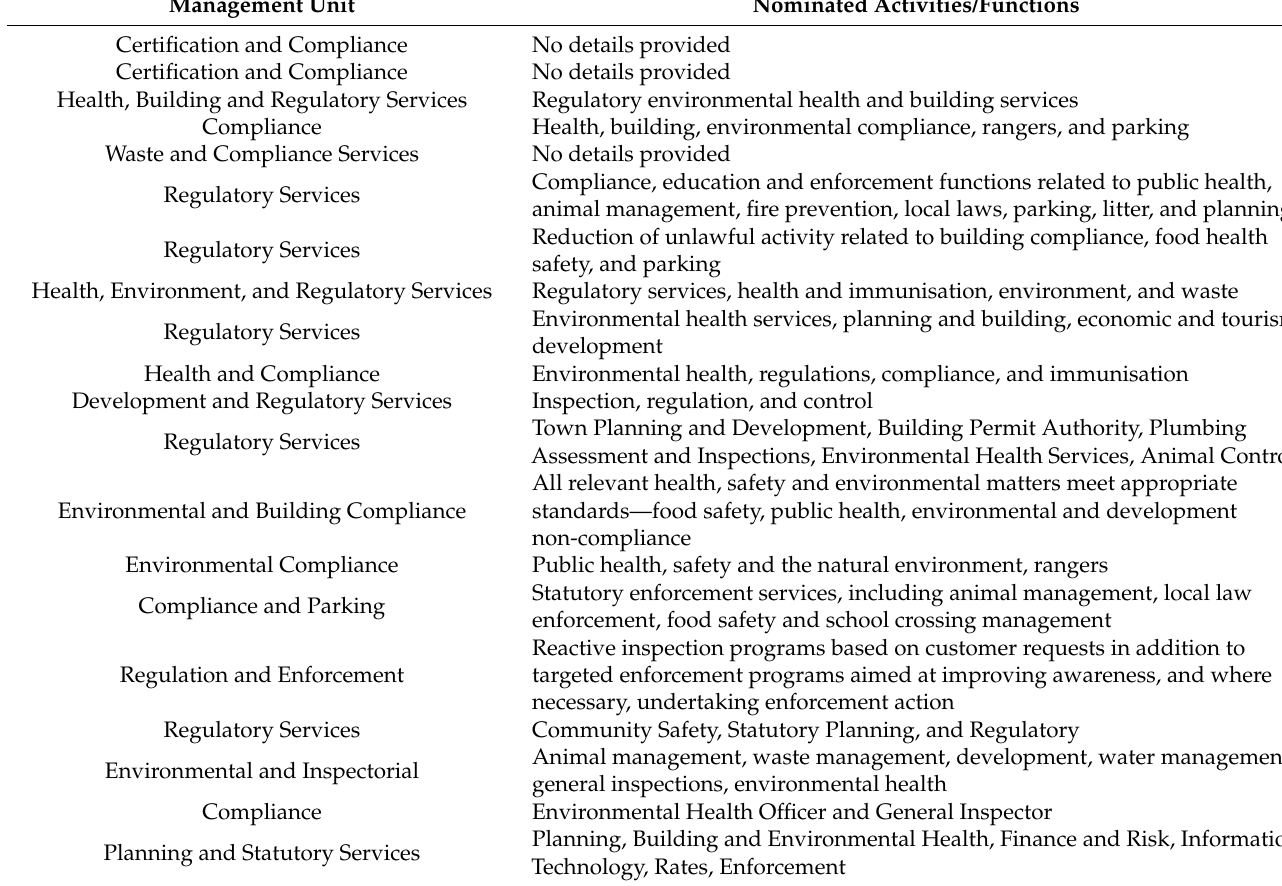
Table 2. Environmental health and sub-departmental functions.